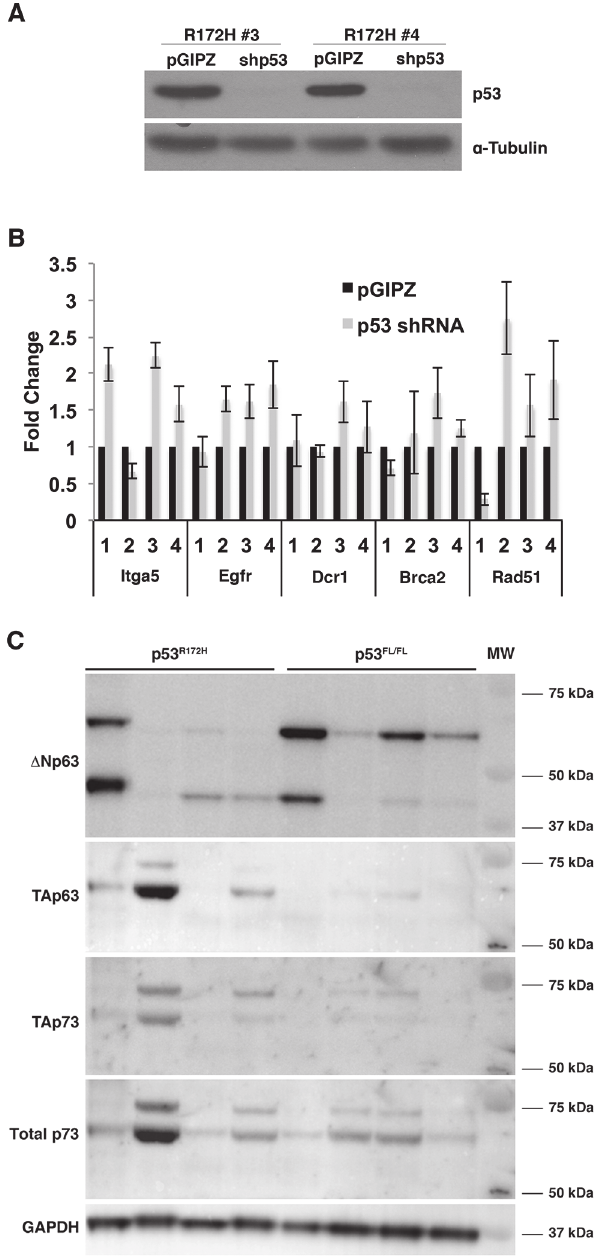
Fig 5. Knockdown of p53 in p53 R172H HCC cell lines results in increased expression of several p53 family transcriptional targets. A) Immunoblot demonstrating knockdown of p53 in cell lines derived from p53 R172H HCCs as compared to pGIPZ empty vector control infections. B) Quantitative RT-PCR analysis of p53 family transcriptional targets in four mouse HCC cell lines with knockdown of p53 R172H . Ct values in each sample were normalized to β -Actin as an endogenous reference. Fold changes were calculated by normalizing all samples to the average Ct value of the cell line ’ s pGIPZ control. The Comparative Ct method was used for fold change calculation. C) Immunoblots demonstrating the expression of p63 and p73 isoforms in p53 fl/fl and p53 R172H HCC cell lines. Note the presence of multiple isoforms within the cell lines. GAPDH is used as a loading control. MW = molecular weight